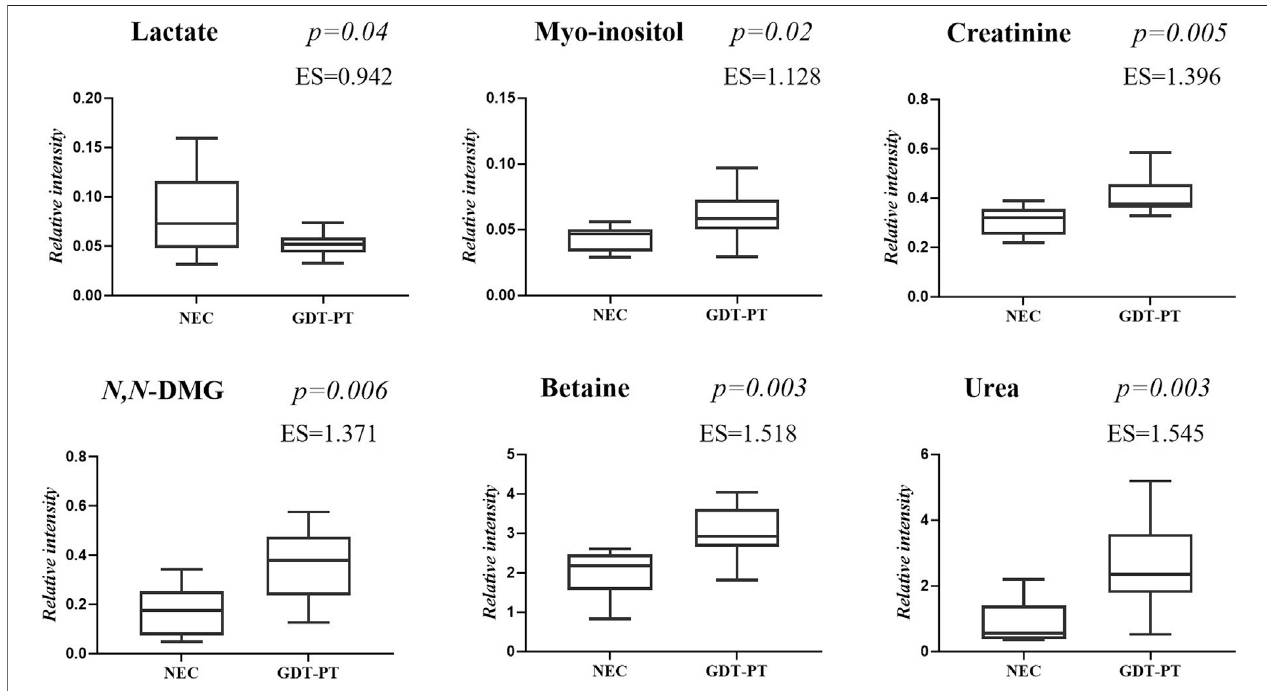
FIGURE 5 | Selected metabolites discriminating control group 3 GDT and late-onset NEC subgroup the day before the onset of the disease and at the disease onset. Values in the box plots are shown as the normalized peak areas of the metabolites.